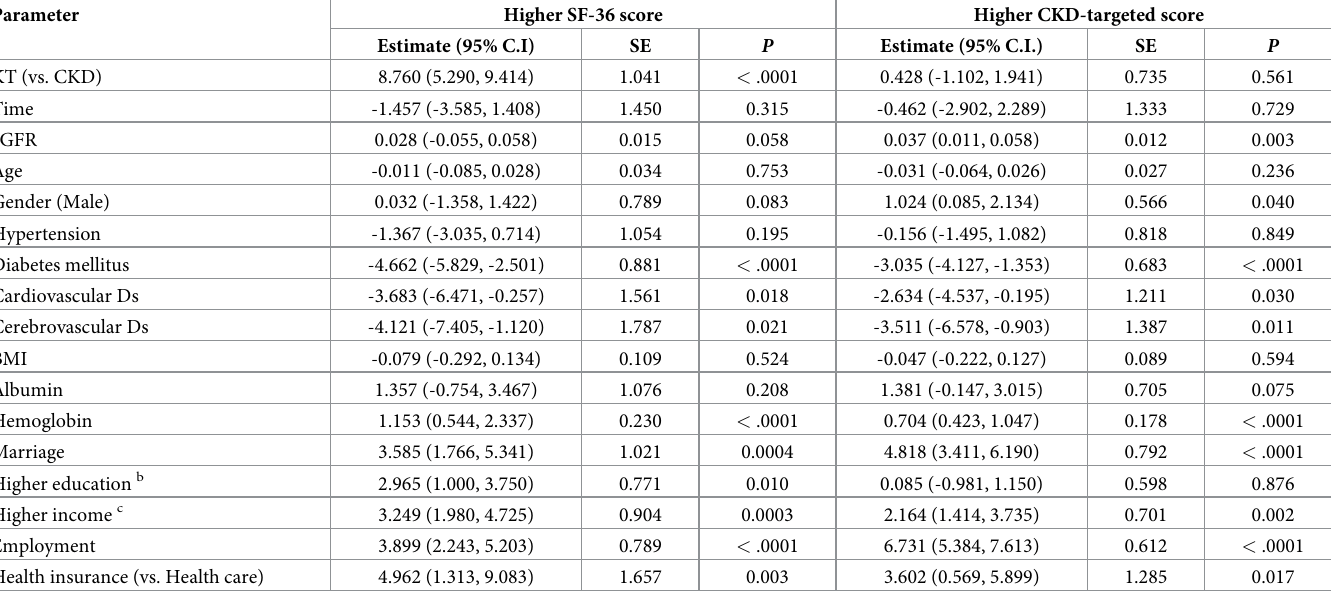
Table 3. Prognostic factors associated with HRQOL in the total population including both KT and CKD patients a